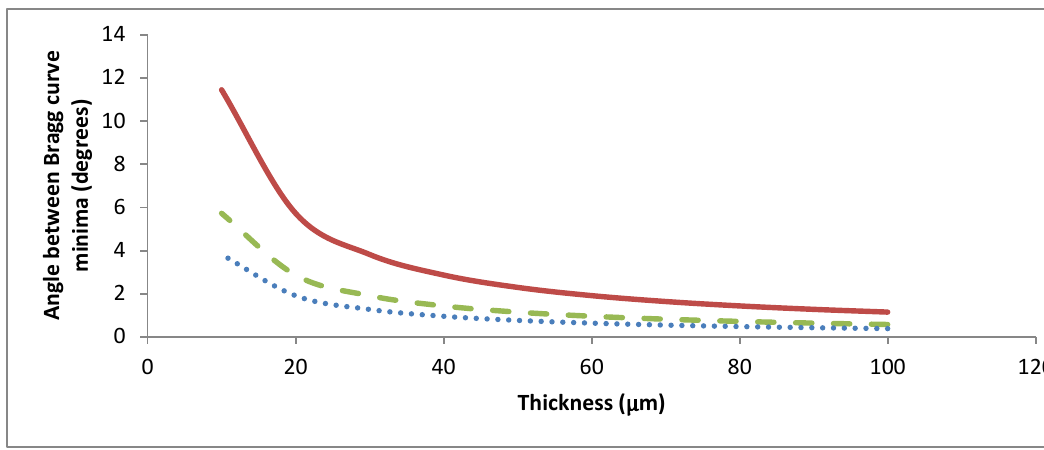
Figure 2. Angle between Bragg curve minima vs. hologram thickness at 500 (solid red), 1000 (dashed green) and 1500 (dotted blue) lines/mm.